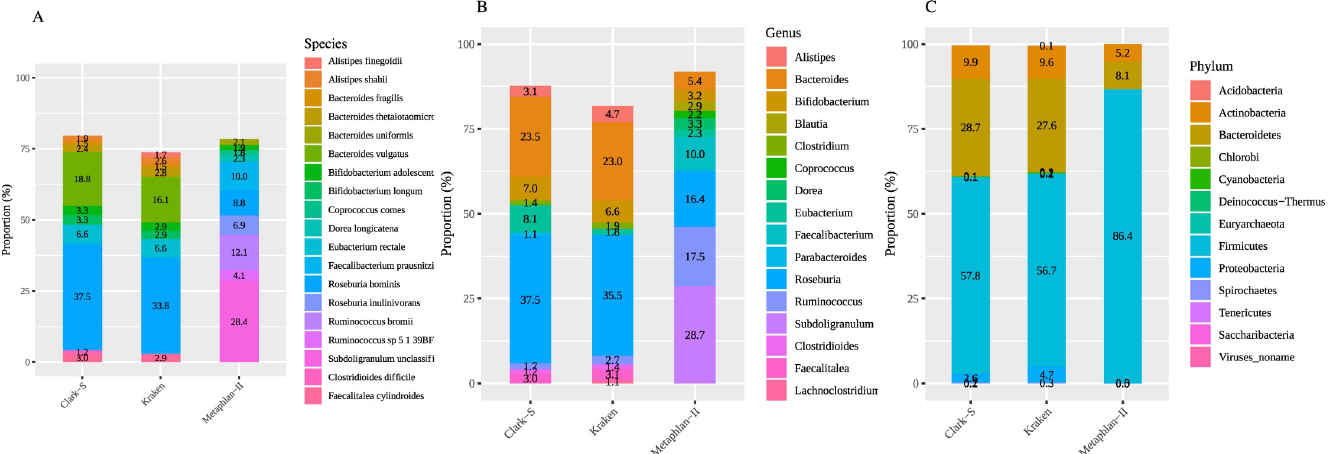
Fig 4. Top-10 taxa predicted at full depth using 3 approaches. A Species. B Genus. C Phyla.